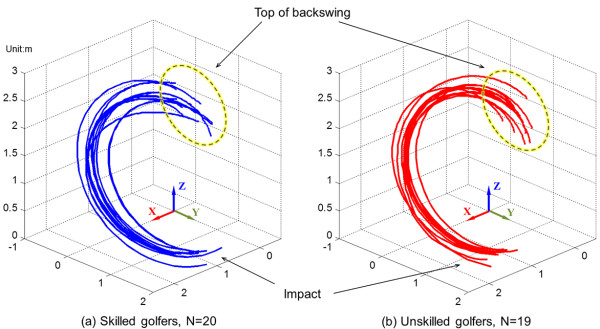
3D traces of a clubhead during the downswing in the skilled (a) and unskilled golfers (b).